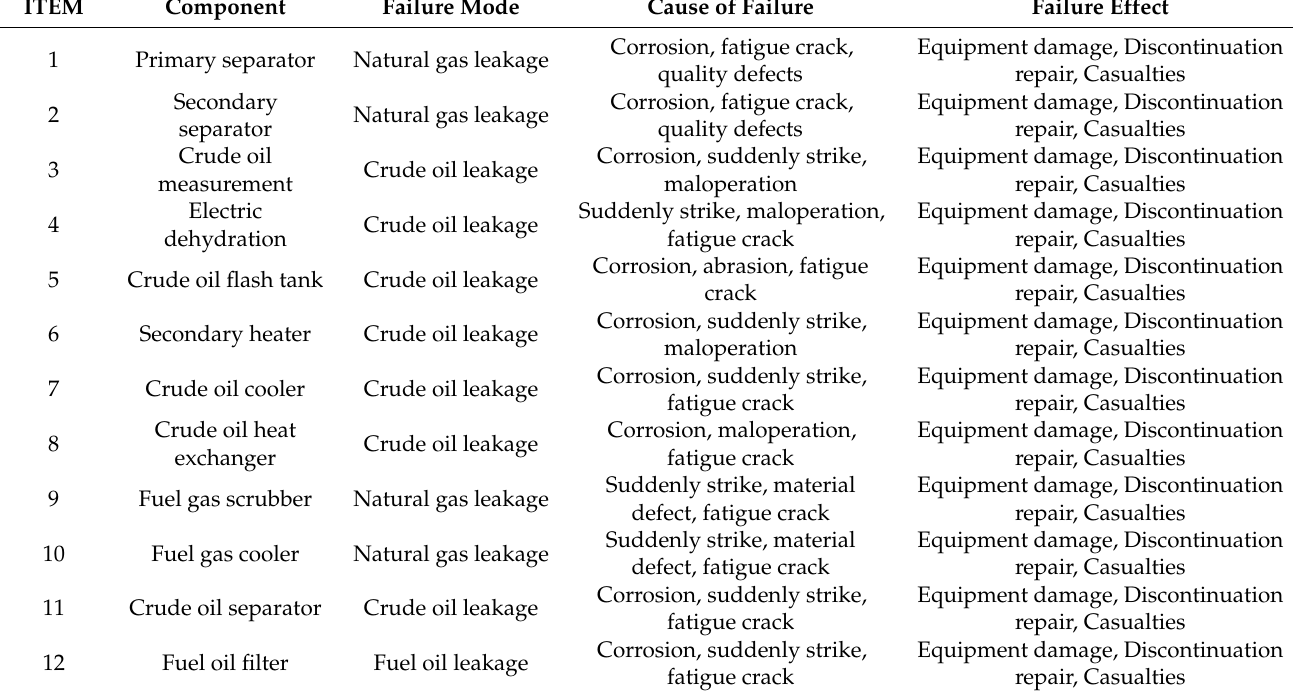
Table 5. Failure mode and effect analysis (FMEA) for FPSO oil and gas processing system.